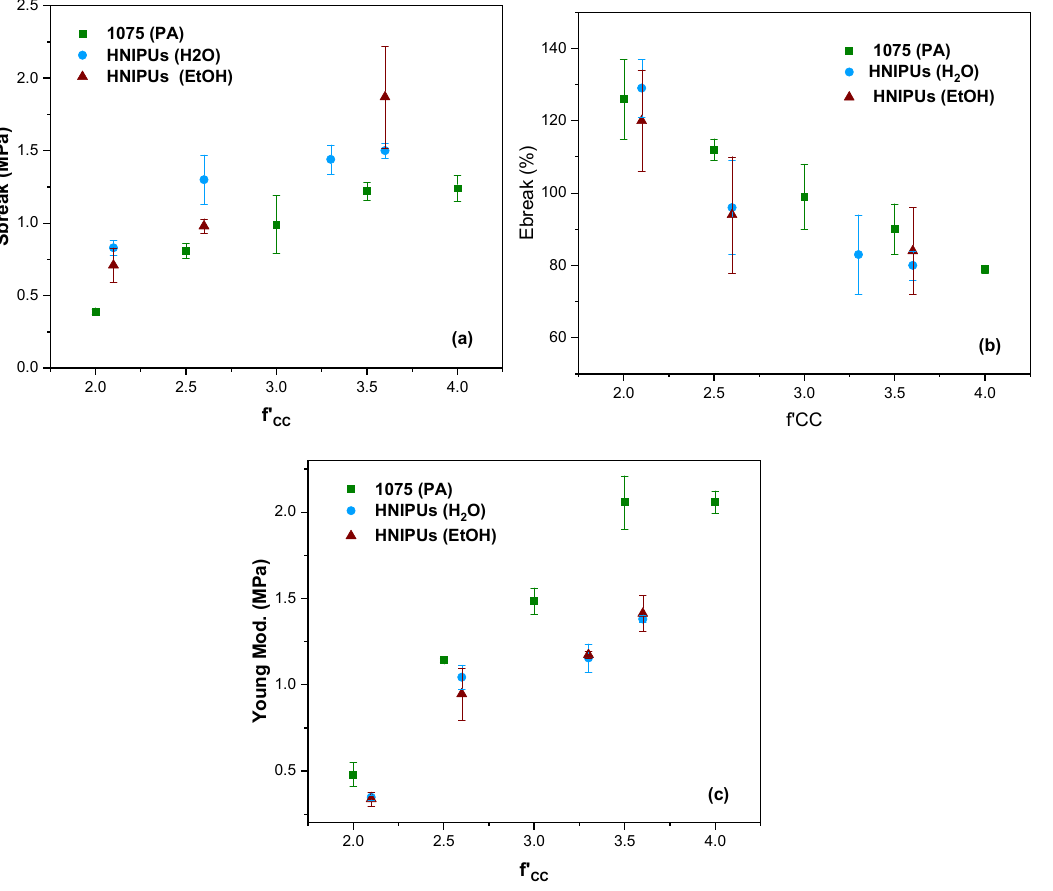
Figure 14. Tensile strength results for H-NIPUs (ASTM 412-D). ( a ) Stress at break, ( b ) elongation at break, ( c ) Young’s modulus .